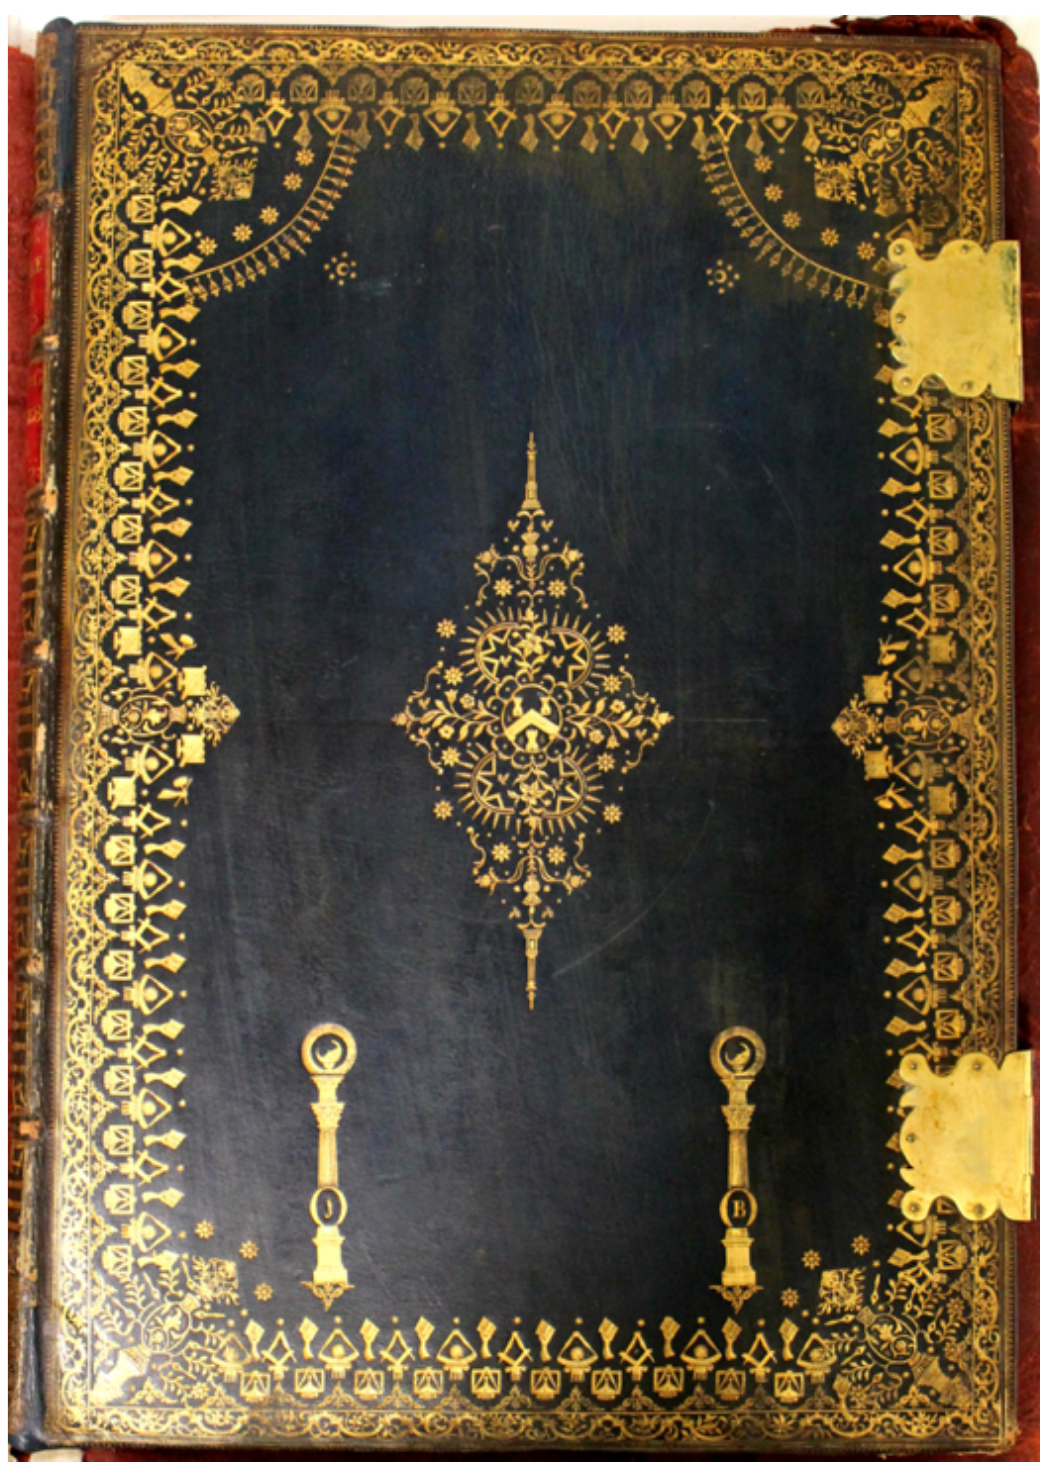
Fig. 29. The ‘Moderns’ membership register (1768-1813). Copyright and reproduced by permission of the Museum of Freemasonry, London. Currently